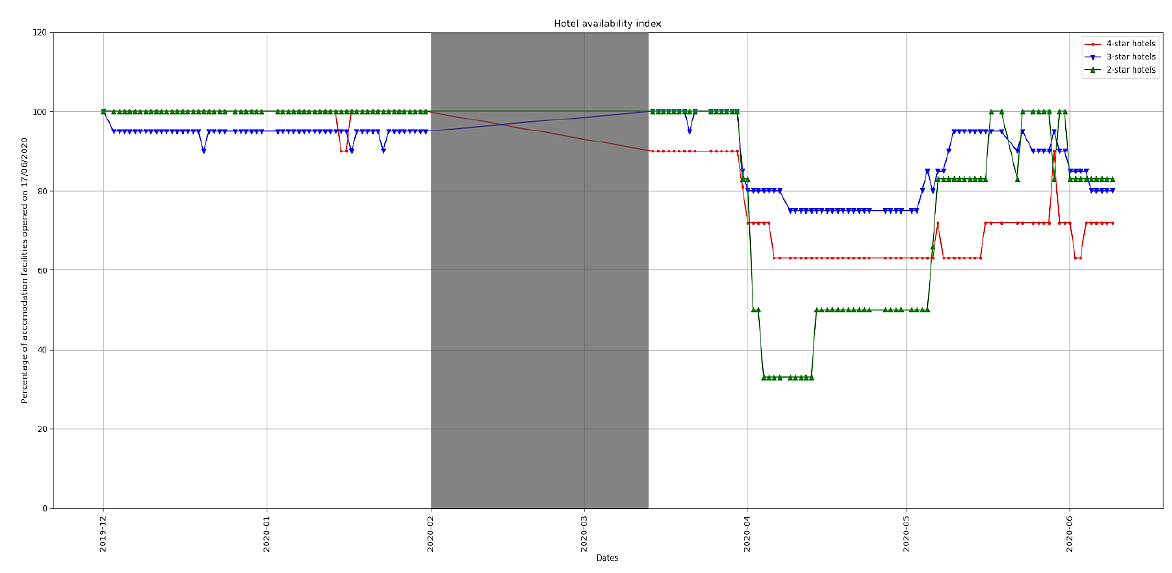
Figure 5. Hotel availability